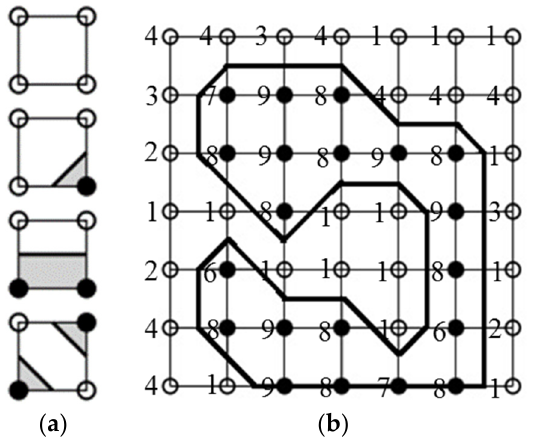
Figure 8. The 2D explanatory drawing of the Marching cube. ( a ) Contour combinations; ( b ) 2D isocontour with the iso-value of 6.